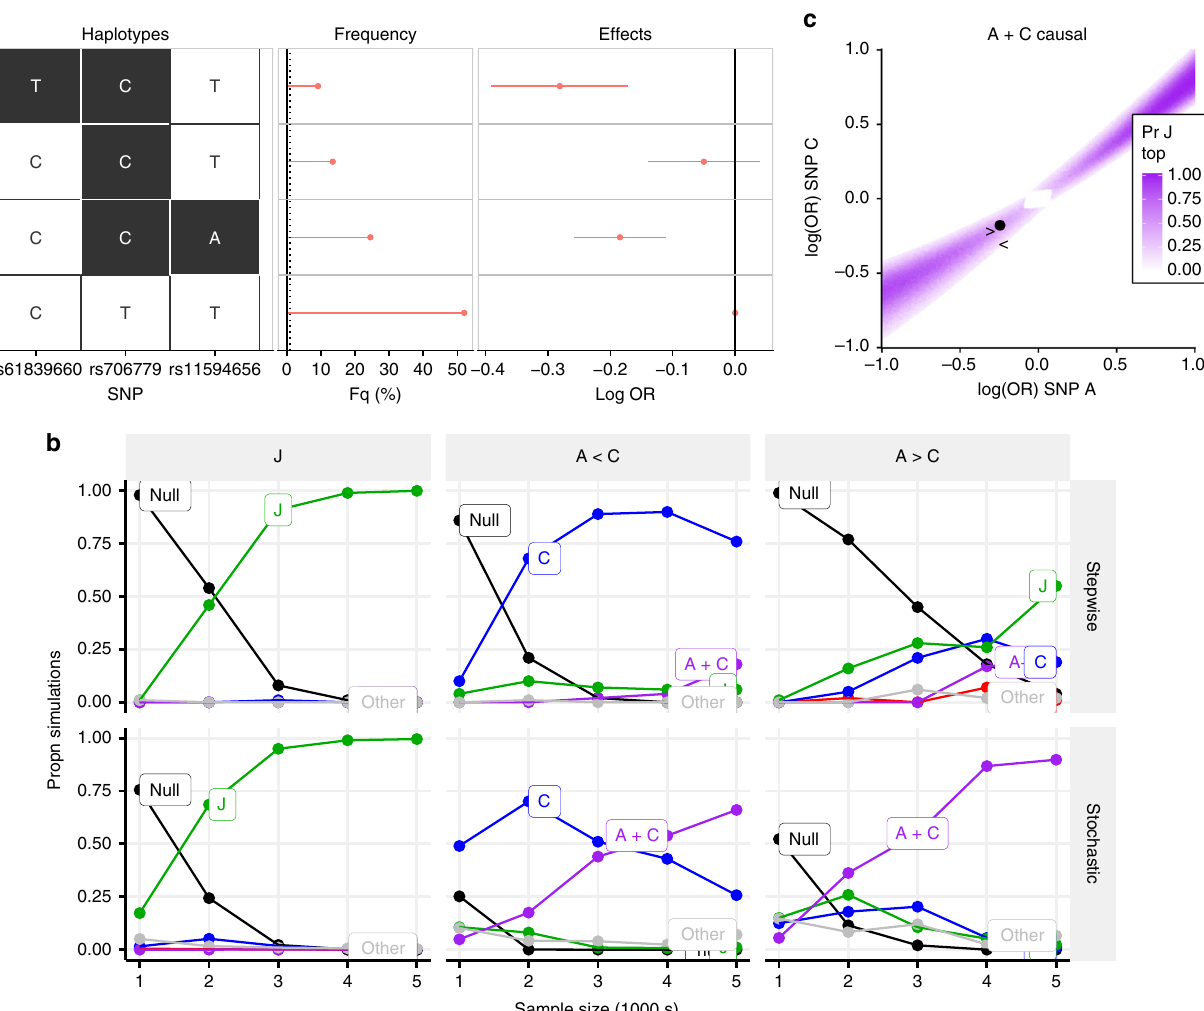
Fig. 1 Evidence for joint tagging. a Haplotype analysis of SNPs selected by stepwise search and GUESSFM for ATD in region 10p-6030000-6220000. A representative SNP from each SNP group is shown. Each column represents one SNP, with possible alleles colour coded according to major or minor. Each row is a haplotype — a speci fi c combination of alleles across all SNPs — with frequency in UK controls and effect on disease risk (log OR + 95% CI). There are four common haplotypes. Three carry the minor allele at the J SNP rs706799, but only those that also carry minor allele at A or C show a signi fi cant effect on disease risk. b Comparison of stepwise and stochastic search applied to simulated data. Causal variants were simulated as follows: J: single causal variant J, OR = 0.8; A < C causal variants A + C, odds ratios A:0.81, C:0.74; A > C: causal variants A + C, odds ratios A:0.74, C:0:8. Potential models include J (green), C (blue), A + C (purple), A (red) and null (black); any other models are grouped together as grey. The y -axis shows the proportion of simulations in which the stepwise approach chose the indicated model (adding SNPs while p < 10 − 6 ) or the average posterior probabilities for each model for the stochastic search approach. Sample size ( x -axis) is the number of cases and controls. c Assuming A and C are causal, this plot shows the probability that J has the smallest p-value as a function of the effect sizes (log odds ratios) at A and C. The estimated effects for A and C from real data are shown by a point, and the simulations from b by < and > for A < C and A > C conditions, respectively. Source data for b are provided in Supplementary Tables 3 –